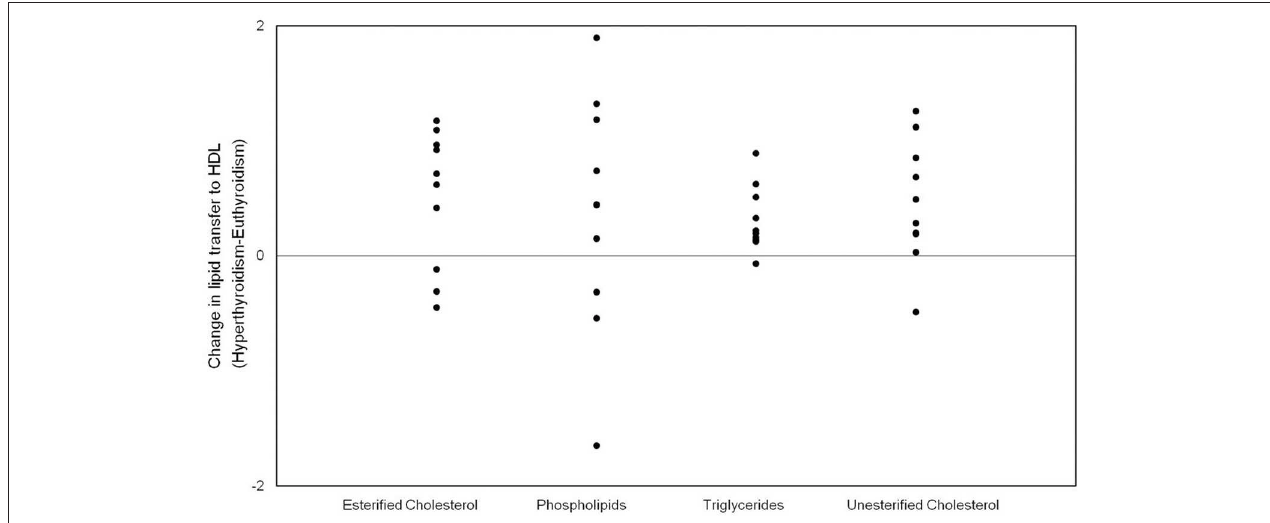
FIGURE 2 | Scattered dot diagram of changes in lipid transfers to HDL between subclinical hyperthyroid and euthyroid